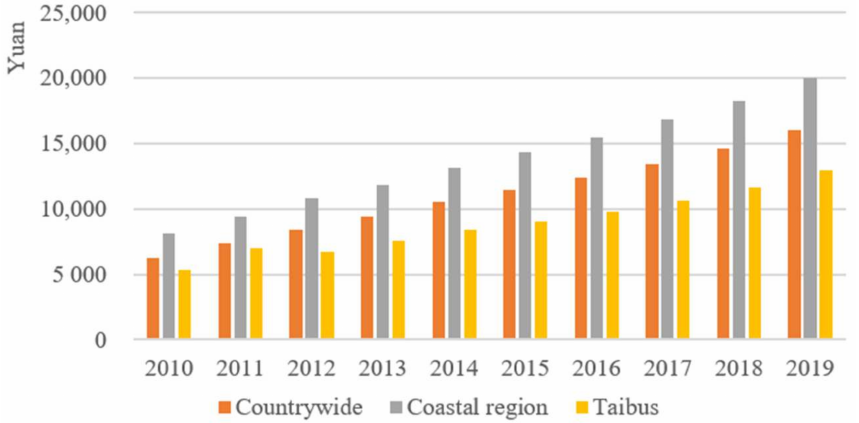
Figure 7. The per capita income of rural population in Countrywide, the Coastal region and Taibus from 2010 to 2019.